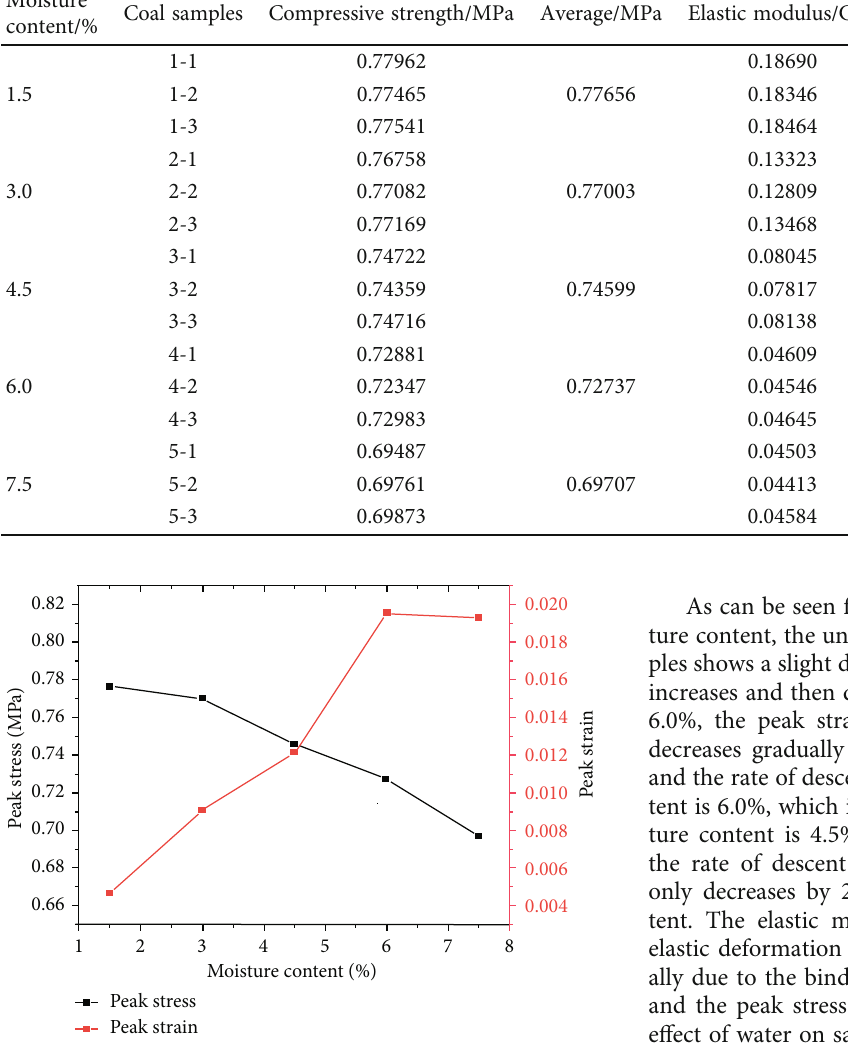
Figure 8: Relationship between compressive strength and peak strain of coal samples with di ff erent moisture